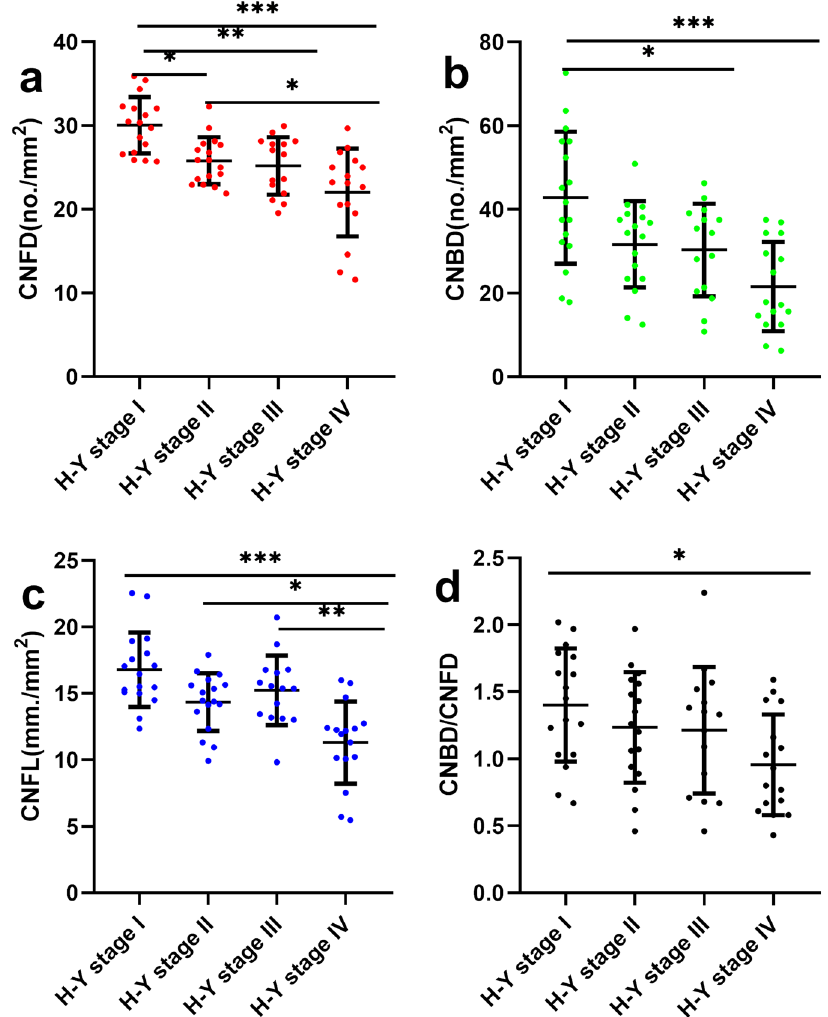
Fig. 5 Association between CCM parameters and disease severity. CNFD ( a ), CNBD ( b ), CNFL ( c ), and CNBD/CNFD ratio ( d ) decreased progressively with increased H-Y stage. Multiple comparisons were performed using analysis of variance (ANOVA) with Bonferroni as post hoc test and Kruskal – Wallis test. Errors bars represent mean ± standard deviation ( *P < 0.05, ** P < 0.01, * ** P < 0.001). Abbreviations: H-Y Hoehn- Yahr stage, PD-CN Parkinson ’ s disease with cognitively normal, PD-MCI Parkinson ’ s disease with mild cognitive impairment, PDD Parkinson ’ s